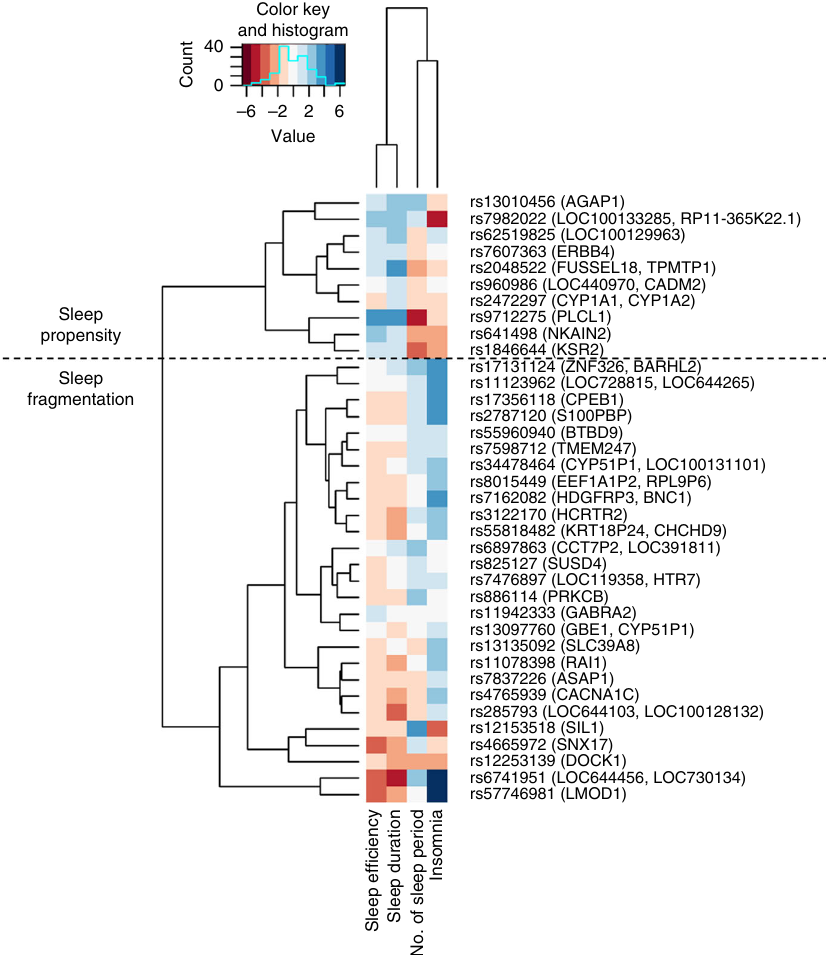
Fig. 2 Daytime sleepiness risk alleles associate predominantly with sleep propensity or sleep fragmentation phenotypes. Each cell shows effect sizes ( z - scores) of associations between sleepiness risk alleles (positively associated with self-reported daytime sleepiness) and sleep traits (accelerometry- derived sleep ef fi ciency, sleep duration, number of sleep bouts, and self-reported insomnia symptoms). Blue color indicates positive z -scores and red color indicates negative z -scores. Sleep propensity alleles were de fi ned as more likely associated with higher sleep ef fi ciency, longer sleep duration, fewer sleep bouts, and fewer insomnia symptoms. Sleep fragmentation alleles were de fi ned as more likely associated with lower sleep ef fi ciency, shorter sleep duration, more sleep bouts, and more insomnia